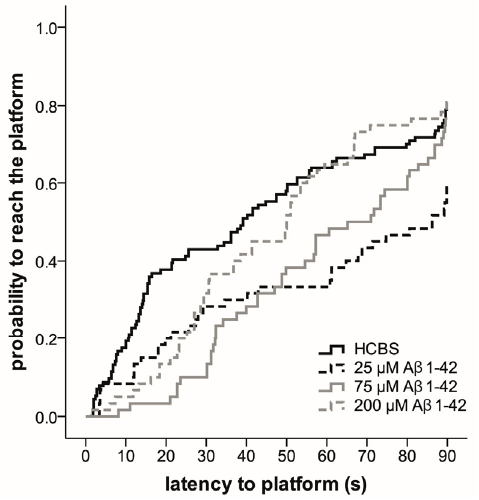
Figure 10. Effect of different aggregation concentrations (25, 75 and 200 µ M) of synthetic A β 1-42 (168 h time) on Morris water maze performance. The fitted survival curves using the Cox Proportional Hazard model represents the probability that animals find the platform during a trial, capped at 90 s. We compared HCBS versus 25 µ M oA β 1-42 ( p = 0.001), HCBS vs. 75 µ M oA β 1-42 ( p = 0.053), and HCBS versus 200 µ M oA β 1-42 ( p = 0.534) treatment groups using log-rank tests ( n = 12/group, except HCBS group, where n =